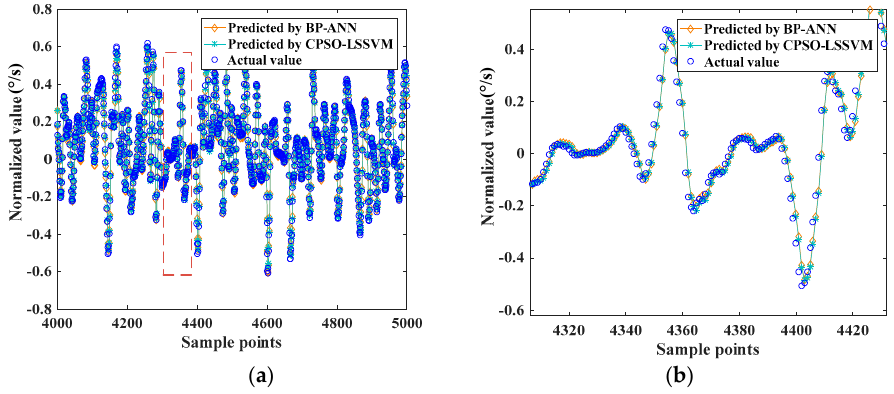
Figure 10. ( a ) The effect of prediction of the testing dataset using BP-ANN and CPSO-LSSVM; ( b ) partially enlarged detail of ( a ). Table 1. The statistical analysis of BP-ANN and CPSO-LSSVM. MAE (mean absolute error); RMSE (root mean square error); ARE (average relative error).